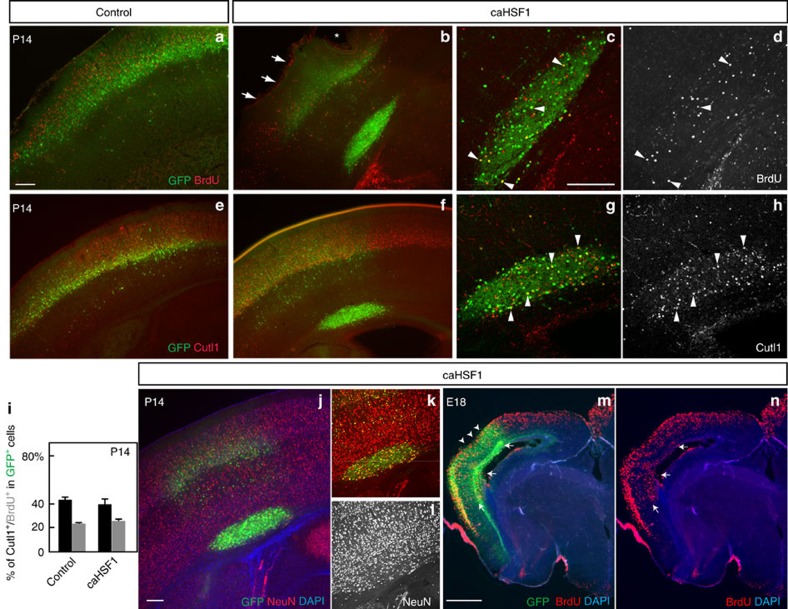
caHSF1 disturbs neuronal positioning without affecting differentiation.(a–h) Mice were electroporated with pCAGIG (control) or pCAGIG-caHSF1 at E14 and stained for BrdU (injected at E15) or Cutl1 (a marker for upper layer neurons) (red or white) at P14. caHSF1-electroporated (GFP+) cells in the heterotopia include Cutl1+ and BrdU+ cells. Most non-electroporated BrdU+ neurons were localized in upper layers (layers II-IV). Arrows and an asterisk indicate disruptions in the marginal zone and pial surface above the heterotopia (b). Arrowheads indicate representative double-labelled cells (c,d,g,h). (i) The percentages of Cutl1+ (black) and BrdU+ (gray) cells within caHSF1-electroporated cells are comparable to those within control-electroporated cells, indicating that caHSF1 does not affect differentiation. Data are represented as mean±s.e.m. P=n.s. by t-test (n=5 each). (j–l) Immunostaining for NeuN (a marker for mature neurons, red or white) on the P14 cortex shows normal neuronal differentiation of caHSF1-electroporated (at E14) cells (labelled with GFP) even within the heterotopia. (m,n) BrdU+ caHSF1-electroporated (at E14) cells (GFP+) were found in deep layers at E18 (arrows). BrdU was incorporated at E15. Disruption in the cortical surface (arrowheads) was already found at E18 in some caHSF1-electroporated samples. Scale bars=0.2 (a–l) and 0.5 (m,n) mm.